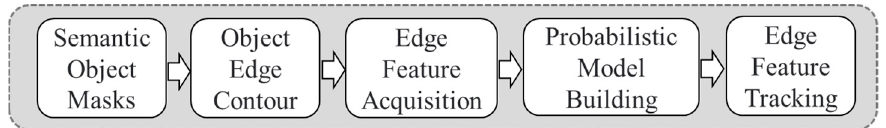
Figure 3. Flow chart of dynamic tracking and extraction of object point and line features.